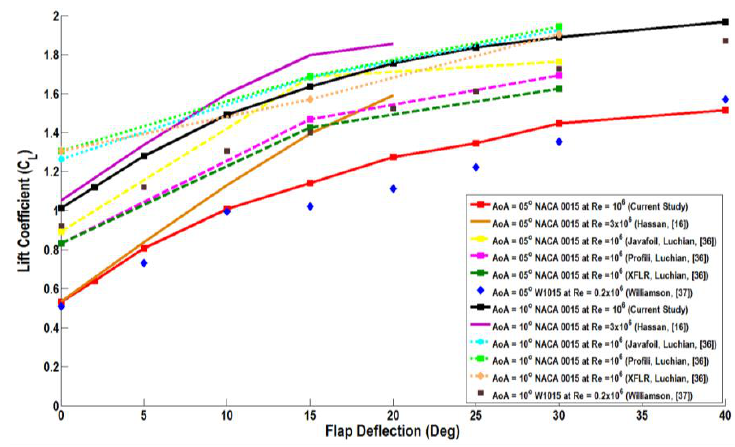
Figure 16. Comparison of effect of flap deflection on lift coefficient for AoA = 5° and AoA = 10° with Hassan’s [16] simulations, Luchian’s [36] results and Williamson’s [37] experiments. different angles of attack of α = 5° and α = 10°. For α = 5°, the drag coefficient of the flapped airfoil increases gradually with the flap deflection up to a flap angle of δ f = 20°, and then, the rate of increase becomes much shaper. For example, the drag coefficient at δ f = 30° is more than two-times its value at δ f = 15°. The trend is somewhat different for the AoA of α = 10°, where the drag coefficient increases gradually with the flap deflection up to δ f = 15°, and then, the drag coefficient increases sharply. The drag coefficient for δ f = 30° in this case is more than five-times its value at (δ f = 10°). When compared with the earlier results, the drag coefficients obtained by the realizable k -ε model in this study are reasonably accurate for the AoA = 5° and in the entire range of flap deflections up to δ f = 30°. It is clear that for the AoA = 10° and δ f > 15°, the predicted drag values are somewhat higher than those predicted by both the Profili and XFLR5 codes, but below the values obtained by the Javafoil code.